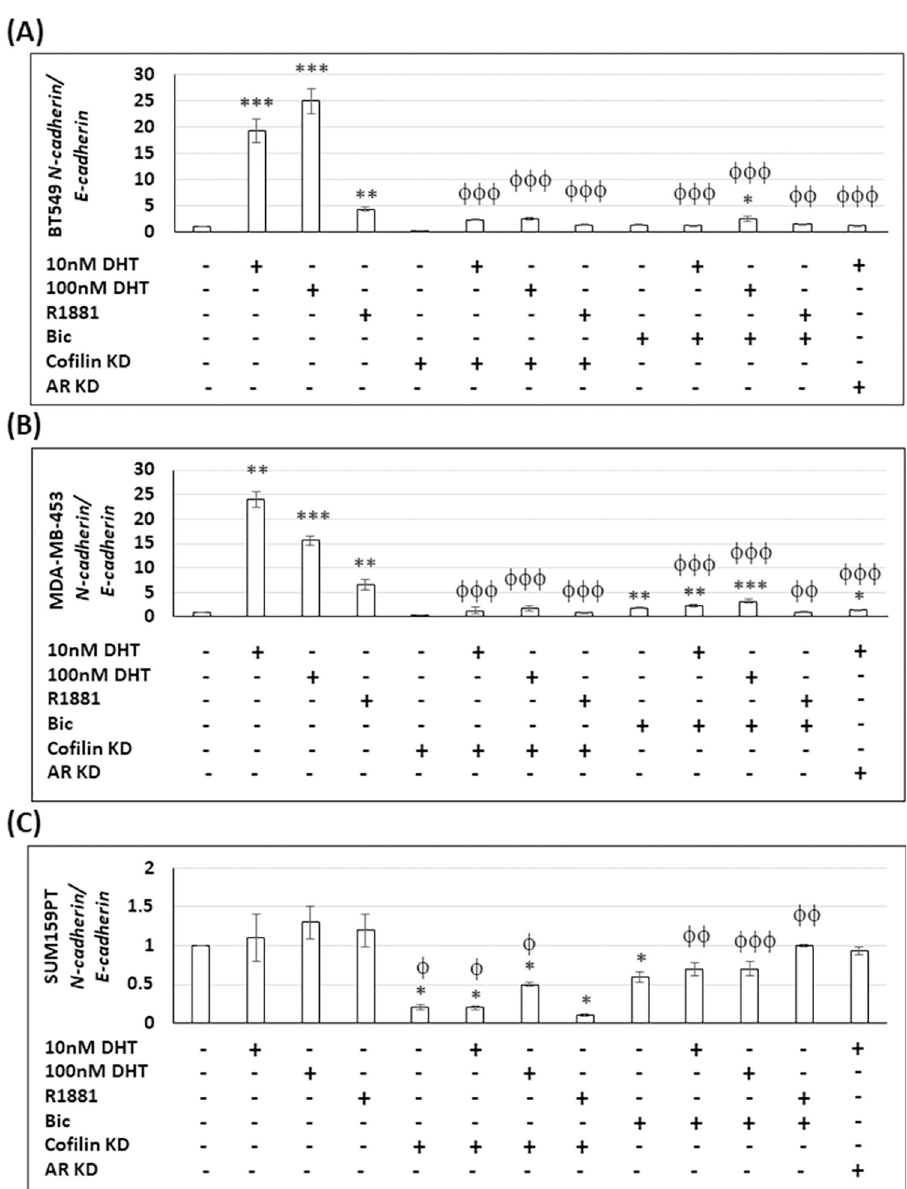
Fig 8. Expressing cofilin shRNA negates androgen effects on N-cadherin/E-cadherin mRNA in TNBC cells. Results shown are N-cadherin/E-cadherin qRT-PCR fold change as compared to vehicle-treated control cells [set as 1 arbitrary unit (a.u.)] in (A) BT549, (B) MDA-MB-453, and (C) SUM159PT cells. Note different scale on Y-axis for SUM159PT cells. Values were normalized to GAPDH . Three independent experiments each performed in duplicate. � p < 0.05, �� p < 0.01, ��� p < 0.001 versus control, ϕ p < 0.05, ϕϕ p < 0.01, ϕϕϕ p < 0.001 versus androgen-treated